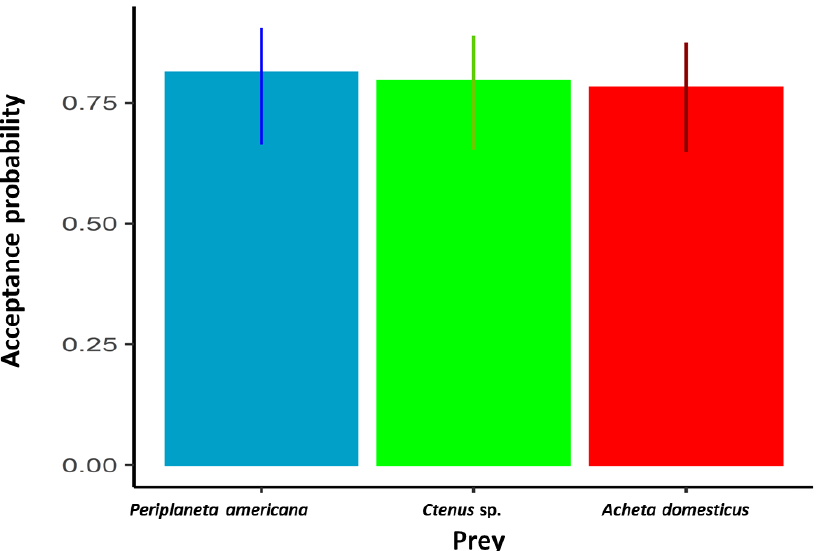
Figure 1. Acceptance probability of Tityus fuhrmanni of spiders ( Ctenus sp.), crickets ( Acheta domesticus ) and cockroaches ( Periplaneta americana ). Bars represent means, lines are 95% confidence intervals. Mean values and confidence intervals were estimated using a generalized estimating equation with a binomial distribution.